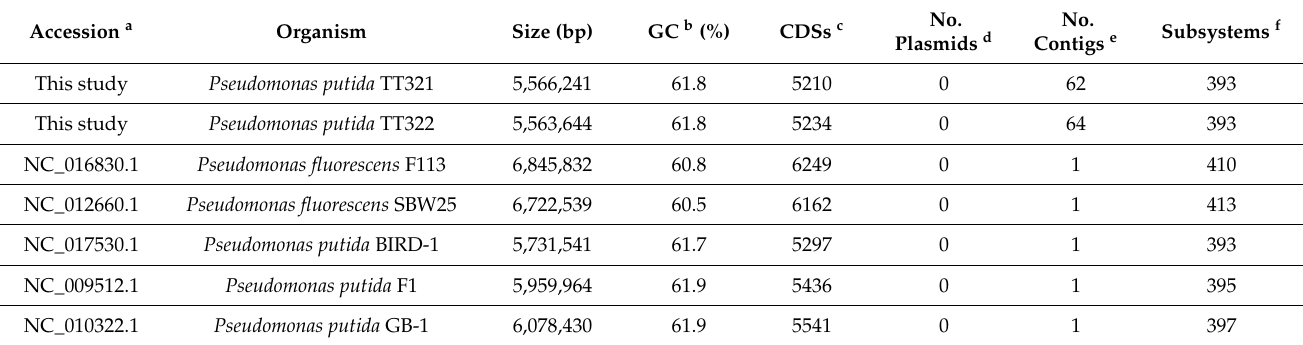
Table 1. Genome characteristics of the 33 Pseudomonas strains used in this